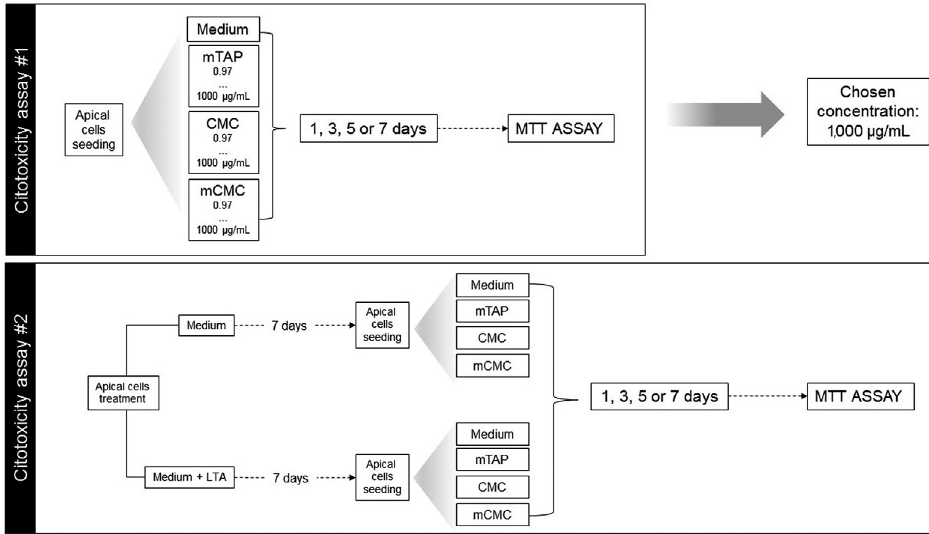
Figure 1- Experimental design for the cytotoxicity study of apical papilla cells